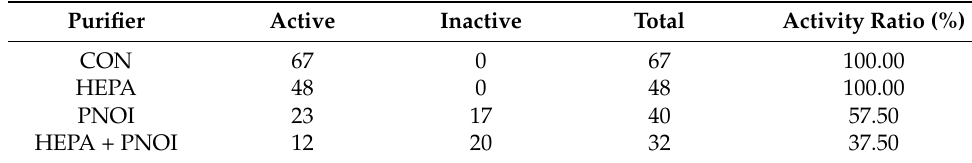
Table 4. Result of influenza virus activity